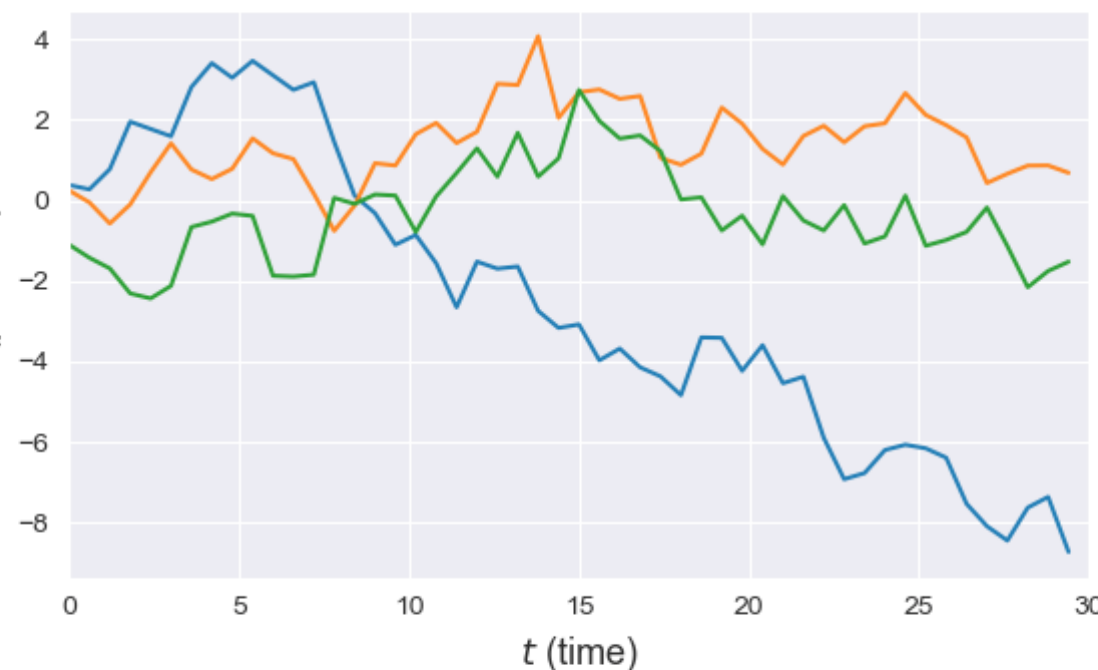
Figure 1. 3 realizations of the Wiener